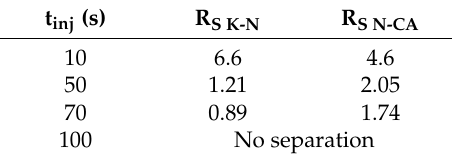
Table 3. Experimental resolution values in function of the injection